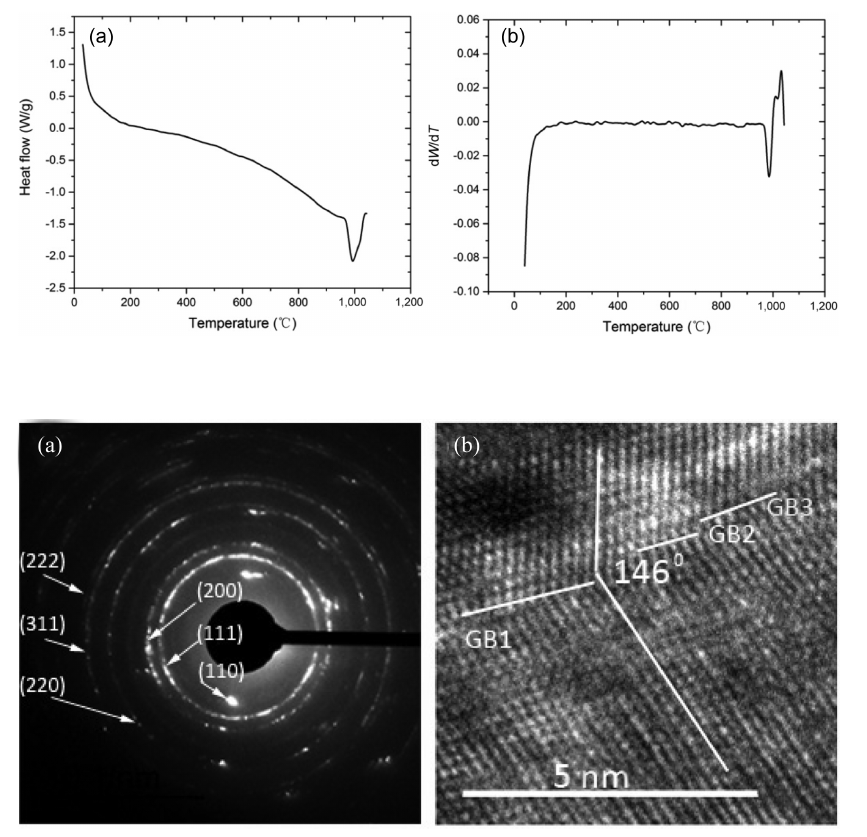
Figure 8: SAED patterns and deformation twin of Ni20Cr micro-wires with engineering strain of 36.1% in wire cross section by transmission electron microscope (TEM).